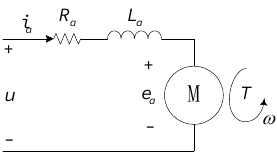
Figure 2. The schematic diagram of the motor.